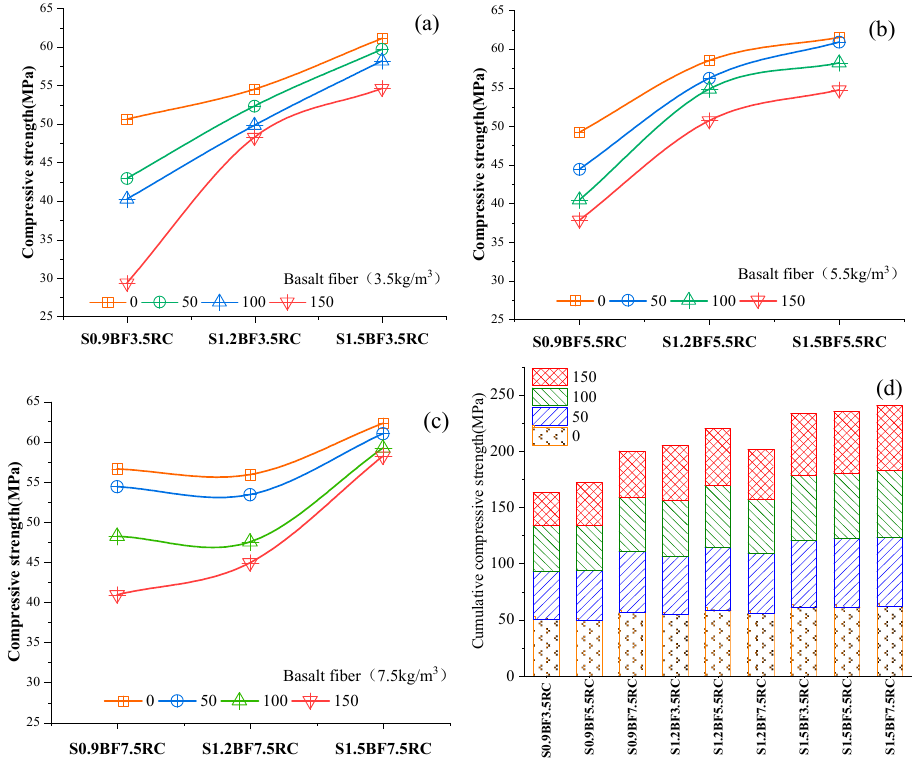
Figure 7. ( a – c ) Change in compressive strength during the freeze–thaw period. ( d ) Cumulative cubic compressive strength of the specimen.